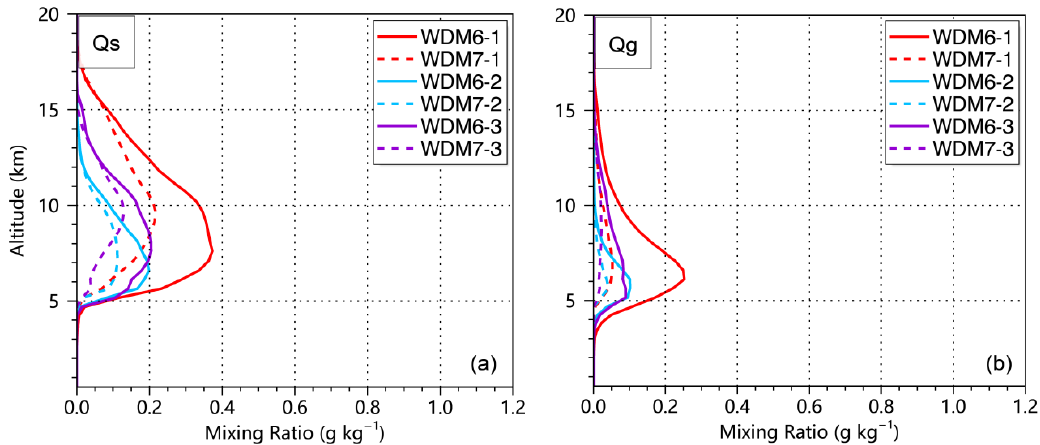
Figure 11. Domain-averaged vertical profiles of ( a ) snow and ( b ) graupel mixing ratio (g kg −1 ) during three different periods of typhoon landfall. The symbol Qx (x = s, g) represents the mixing ratio of each hydrometeor species, and the appending digits -1, -2, and -3 in the legend represent the periods before, during, and after landfall, respectively. Note WDM6 scheme is the same as WDM7 scheme, but without the hail